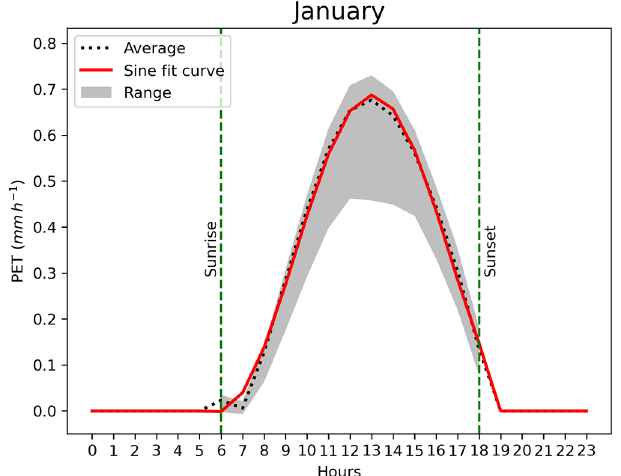
Figure 1. An example of a sine function curve fitted over the aver- age hourly PET values for January at a location in Wajir (Kenya). The black dotted line is the average from hPET, and the red solid line represents the fitted sine function. The grey shaded area is the range across all January days in the 40-year record for hPET. Av- erage sunrise and sunset times are shown in green vertical dashed lines.